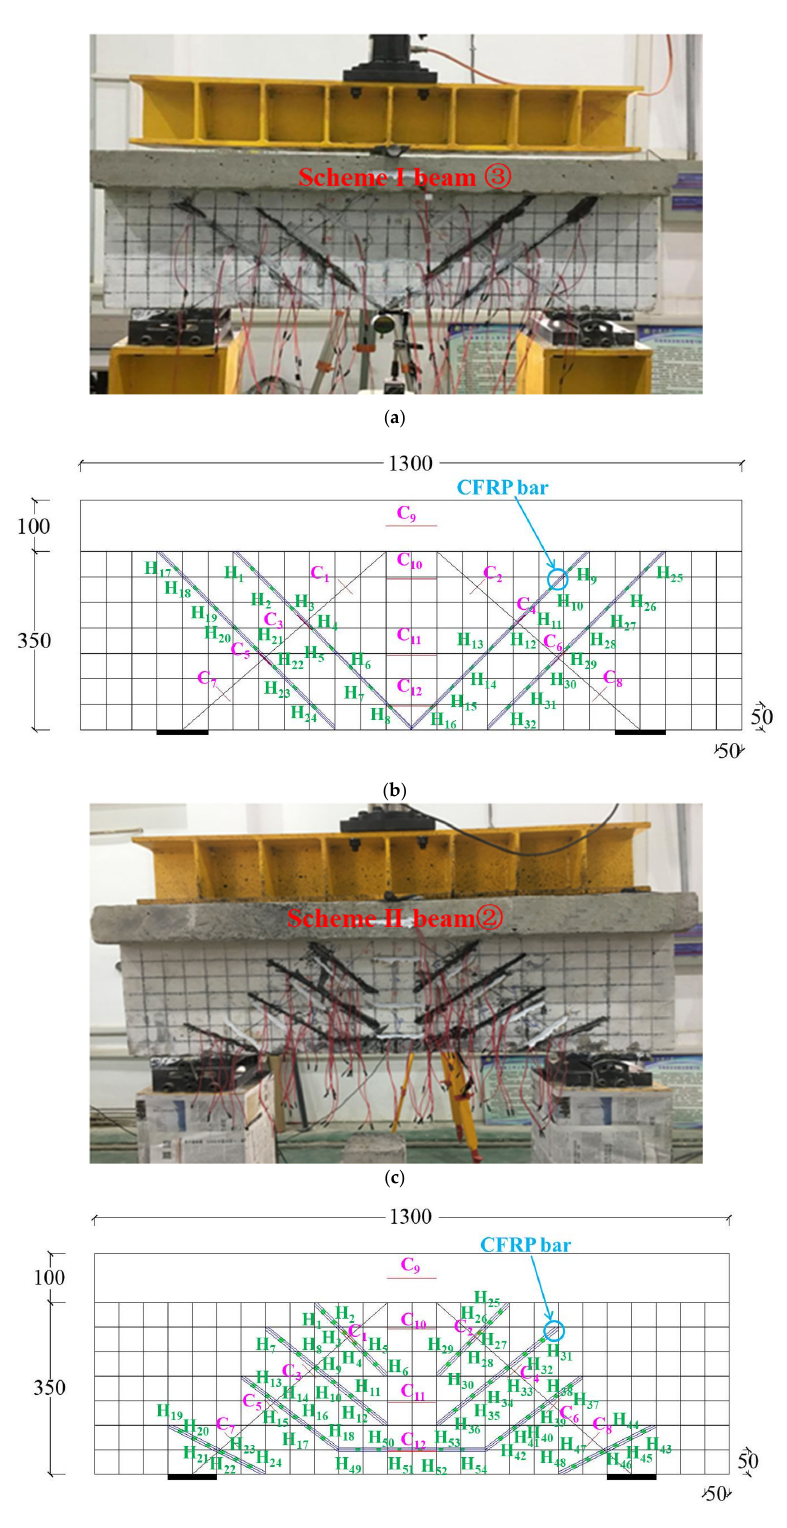
Figure 13. Deep T-beams under three-point bending loading: ( a ) Reinforced beam by Scheme I; ( b ) The location of strain gages in scheme I beam. Note: strain gages C1–C12 are pasted on beam surface, strain gages H1–H32 are pasted on CFRP bars surface; ( c ) Reinforced beam by Scheme II; ( d ) The location of strain gages in scheme II beam. Note: strain gages C1–C12 are pasted on beam surface, strain gages H1–H54 are pasted on CFRP bars surface.